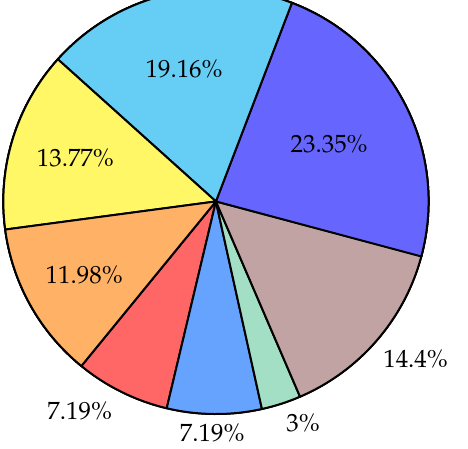
Figure 8. Distribution of papers by industry